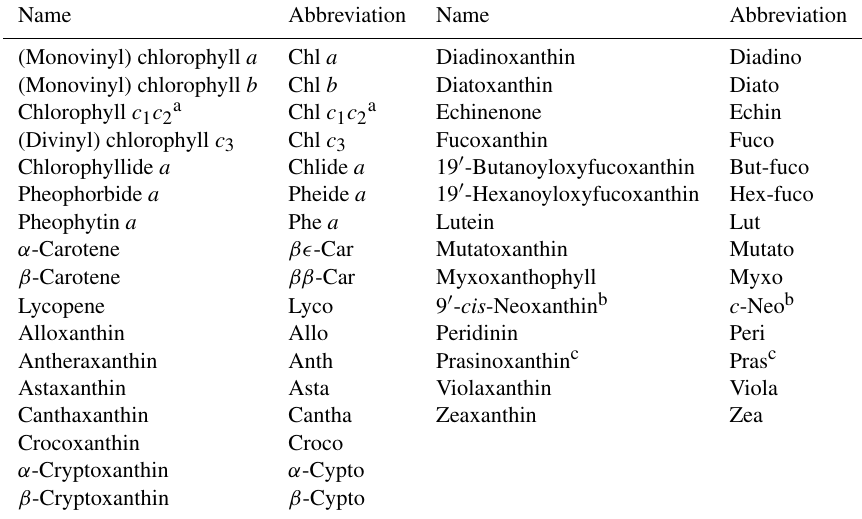
Table 6. List of quantified pigments. Names and abbreviations follow Roy et al. (2011). Known co-elutions according to Van Heukelem and Thomas (2001) are described in the table